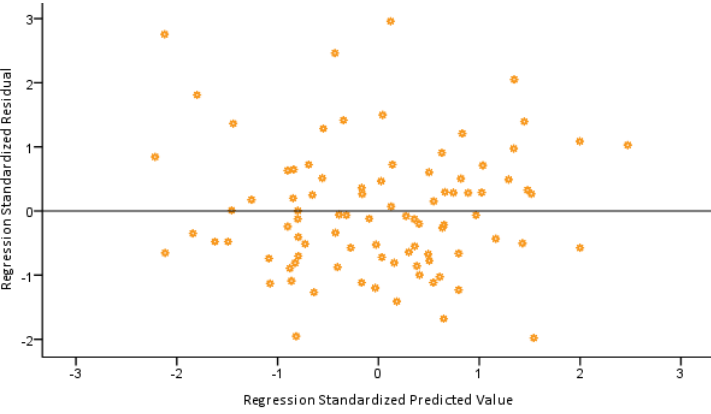
Fig. 5: residual scaterplots for homoscedasticity assumption